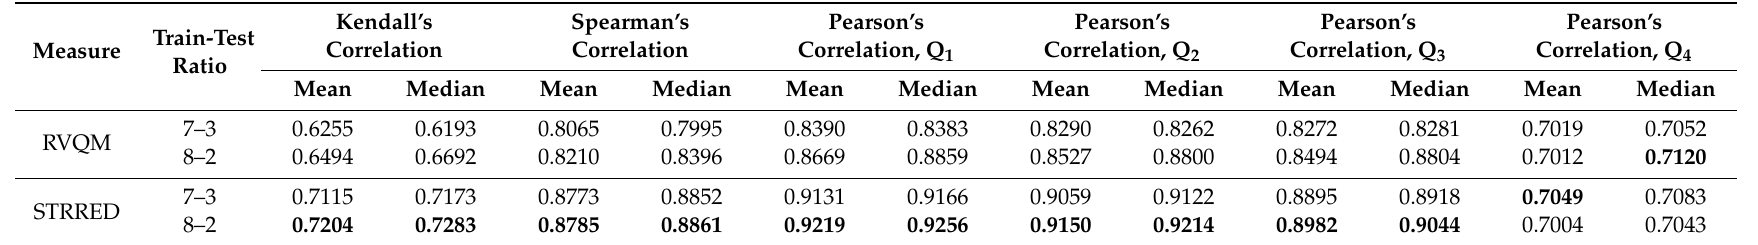
Table 9. Kendall’s, Spearman’s, and Pearson’s correlation for di ff erent train-test dataset ratio (best values are marked in